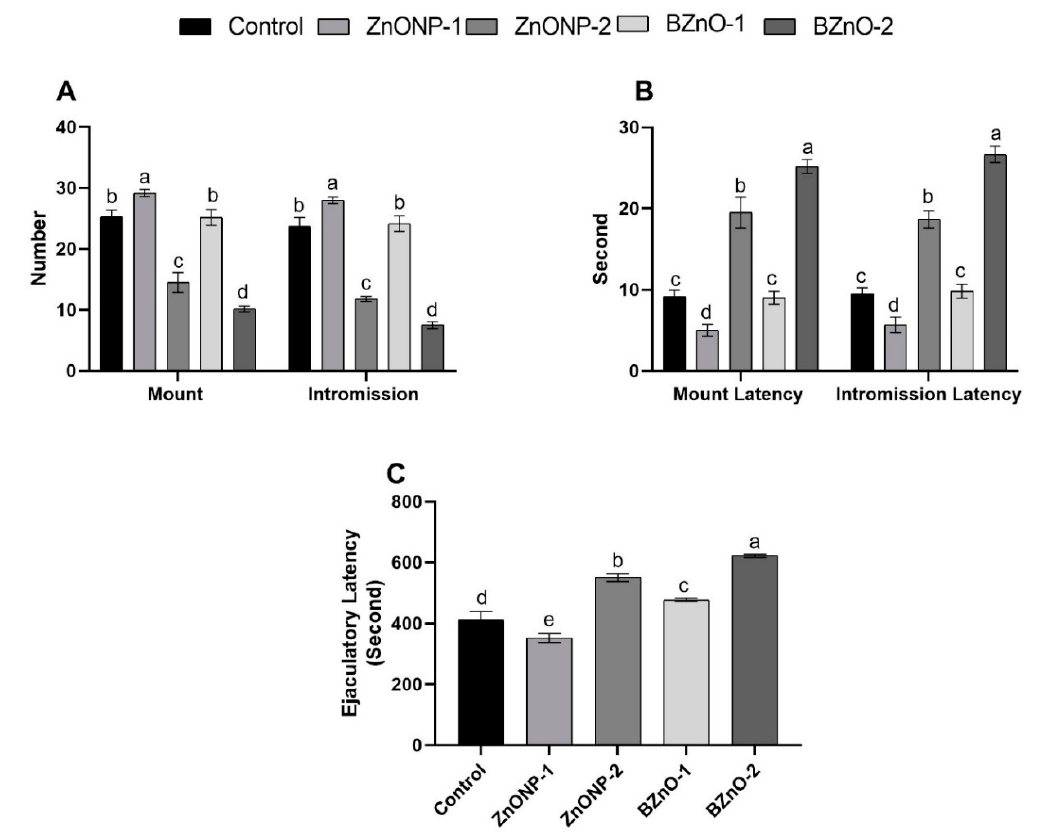
Figure 2. Effect of the ZnONPs and bulk zinc oxide (BZnO) at different doses on the sexual behavior of male rats: ( A ) mount and intromission numbers; ( B ) mount and intromission (seconds) latencies; and ( C ) ejaculatory latency (seconds). All the values are expressed as the mean ± SEM. Different small letters (a–e) indicate significance at p < 0.0001.